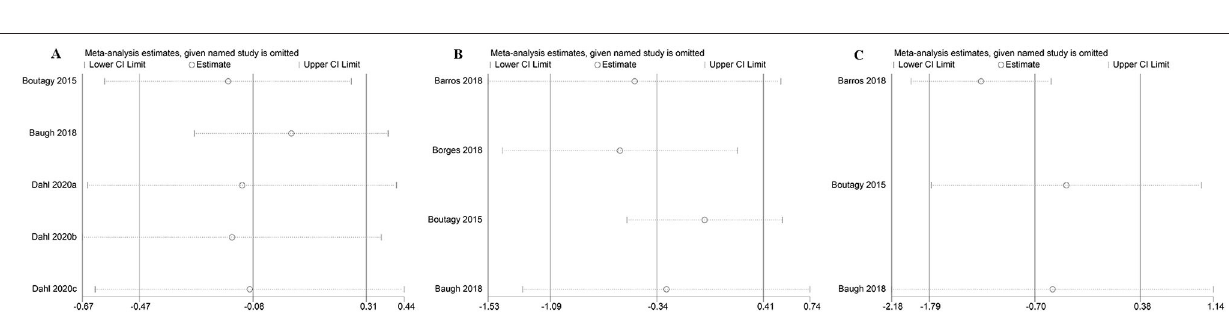
FIGURE 14 | Published bias egger test for the effect of microbiota-driven therapy on circulating TMAO level.